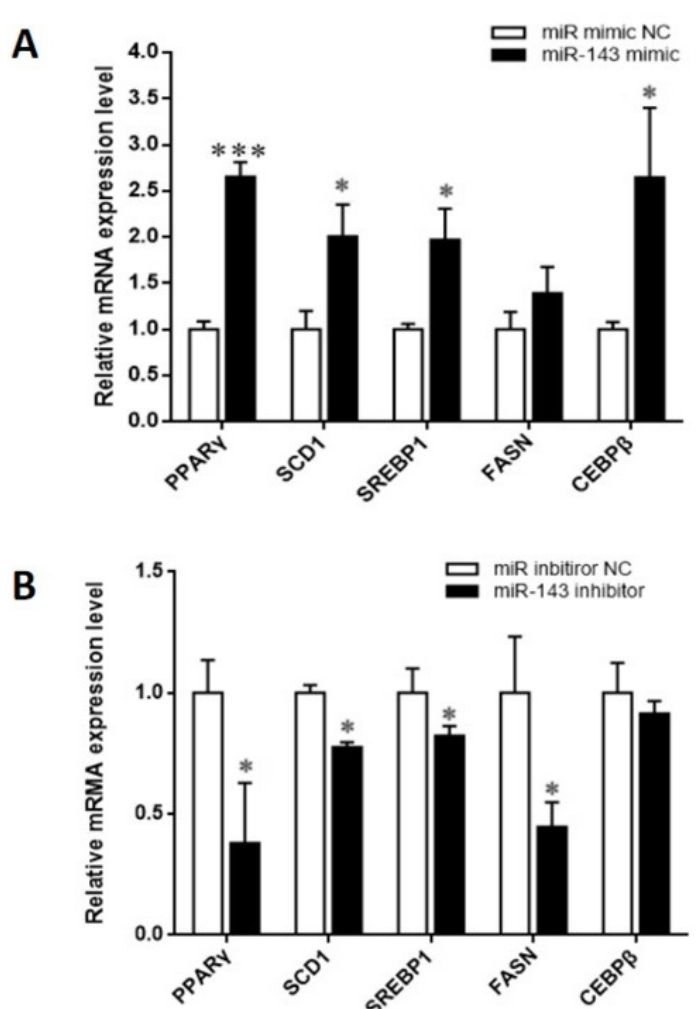
Figure 3. Effects of miR-143 on the expression of the genes related to lipid metabolism. ( A ) BMECs were transfected with miR-143 mimic; ( B ) BMECs were transfected with miR-143 inhibitor. * p < 0.05, ** p < 0.01, and *** p < 0.001.